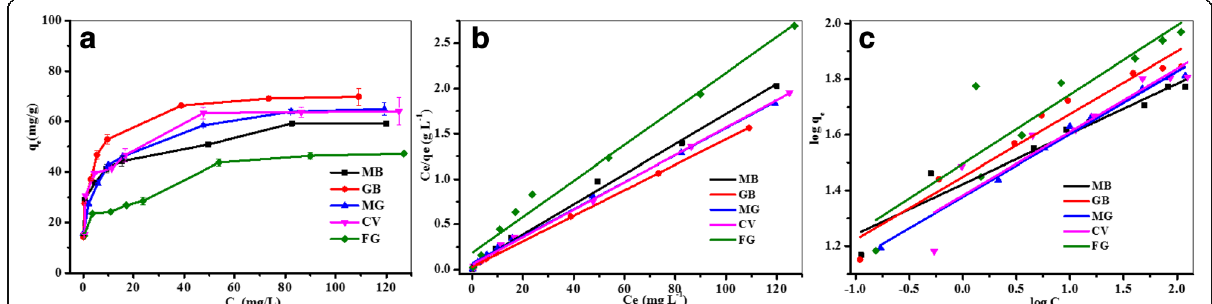
Fig. 5 a Isotherms of cationic dyes adsorption on Fe 3 O 4 /PCC MNPs ( b ) Langmuir and ( c ) Freundlich adsorption isotherm models for organic dyes by Fe 3 O 4 /PCC MNPs. As shown as Fig. 5, the blank line represent the adsorption of MB, the red line reperesent the adsorption of GB, the blue line represent the adsorption of MG, the magenta line represent of CV adsorption, and the olive line is on behalf of the adsorption of FG